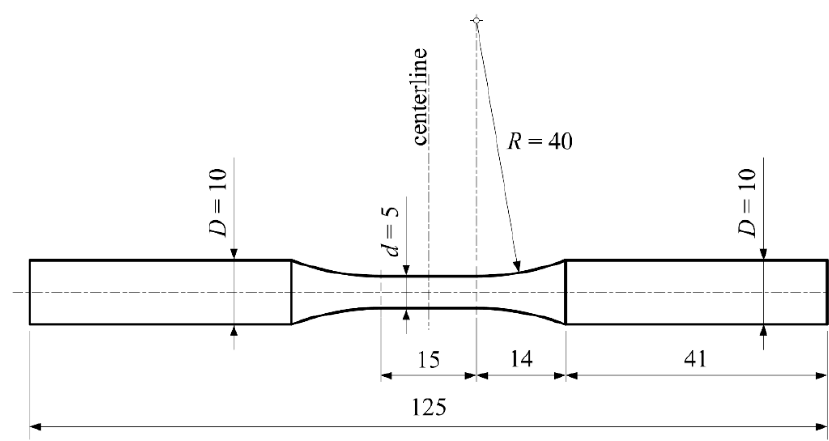
Figure 3. Specimen’s geometry (mm): fatigue test.